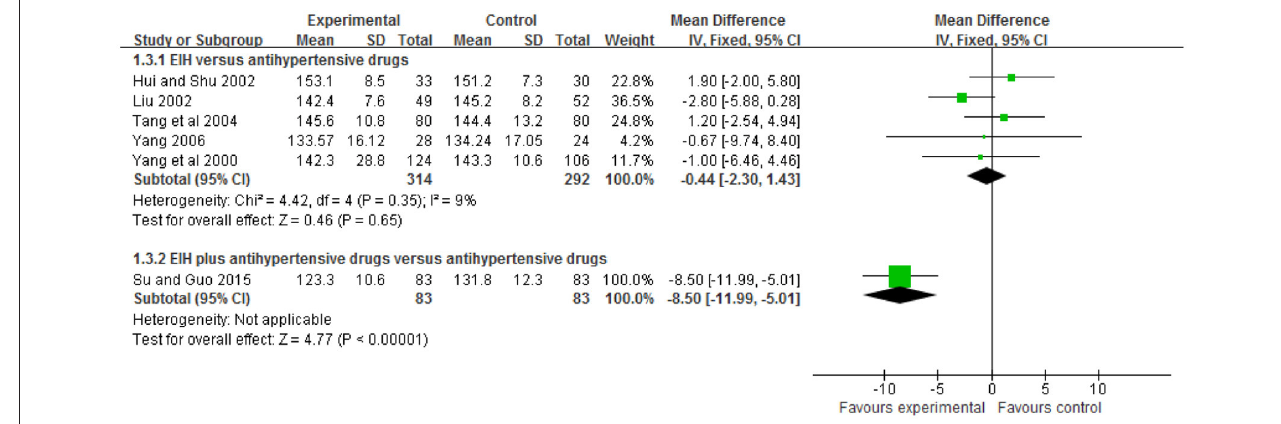
FIGURE 4 | The forest plot of comparison of two groups for the outcome of systolic blood pressure.